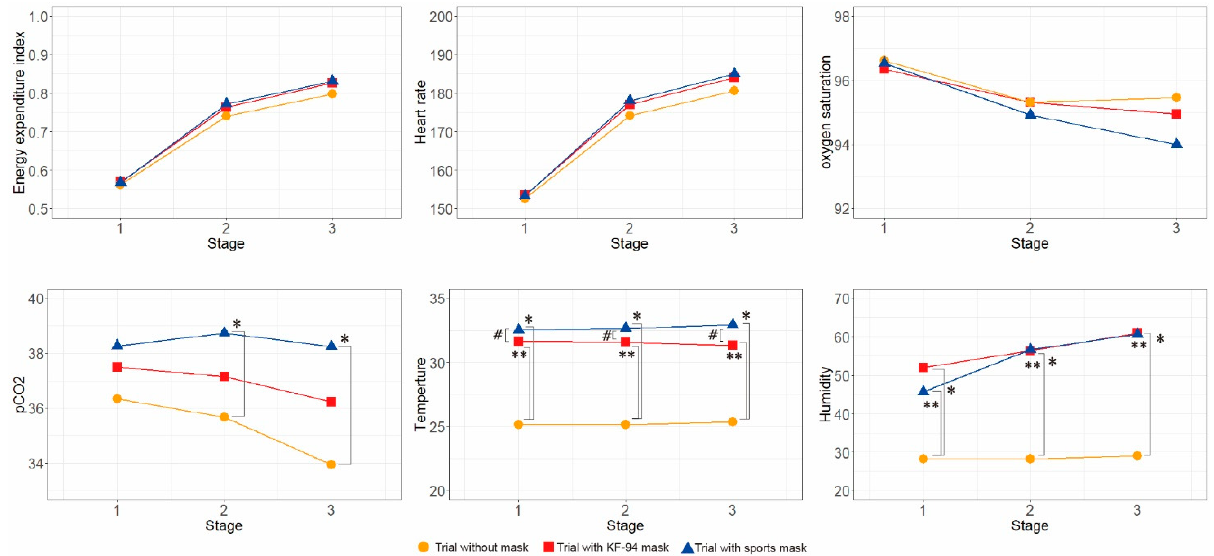
Figure 3. Comparison of physiologic parameters among KF-94 mask, sports mask, and no mask conditions. Data were analyzed using the paired t-test or Wilcoxon signed-rank test depending on the normality compared between conditions. * p < 0.05 when comparing trials between no mask and sports mask conditions, ** p < 0.05 when comparing trials between no mask and KF-94 mask conditions, # p < 0.05 when comparing trials between KF-94 mask and sports mask conditions.